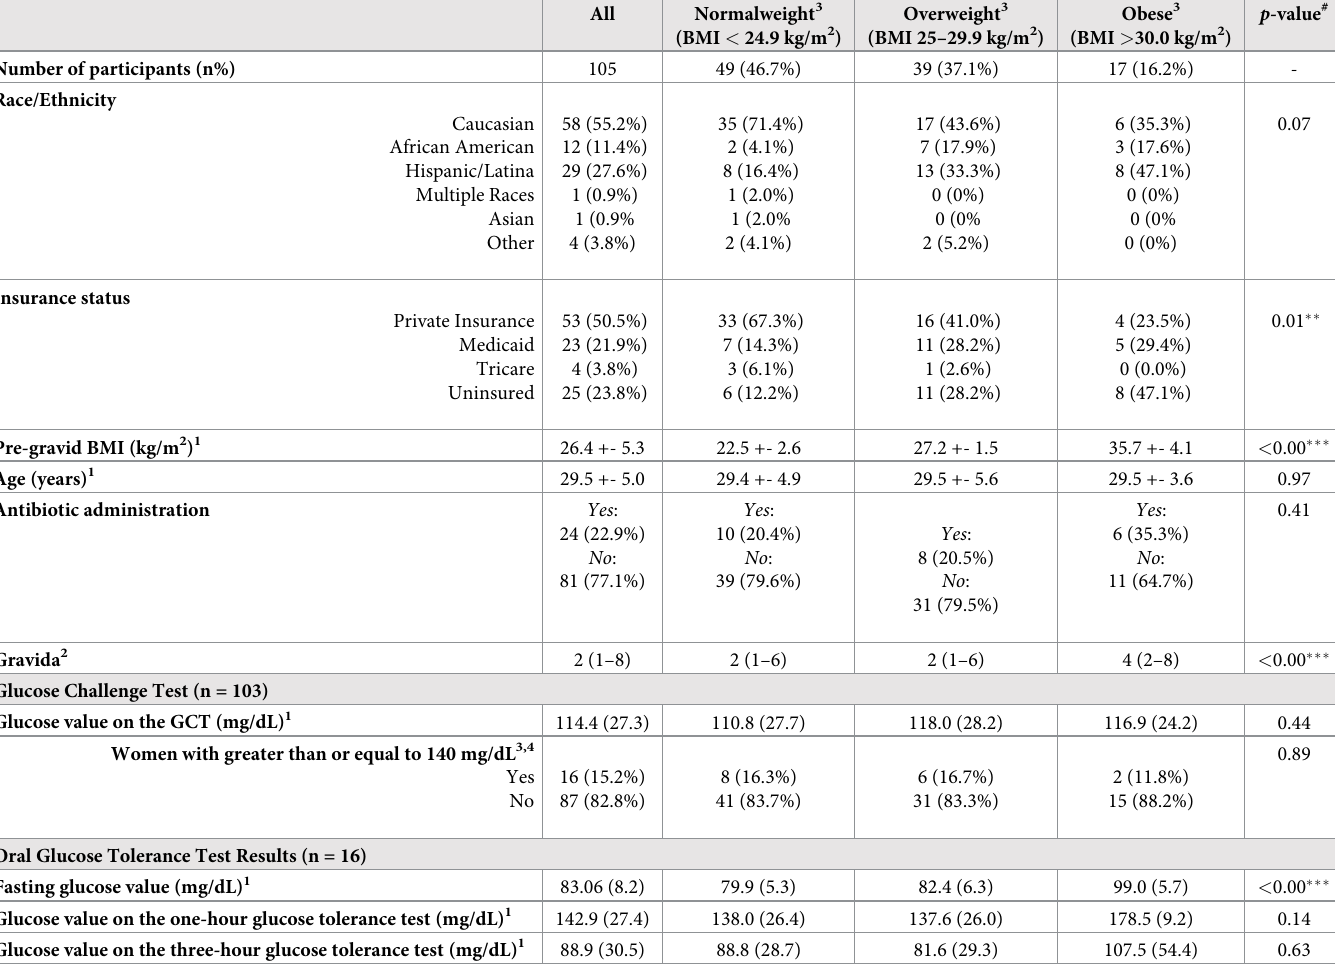
Table 1. Participant characteristics by pre-gravid body mass index